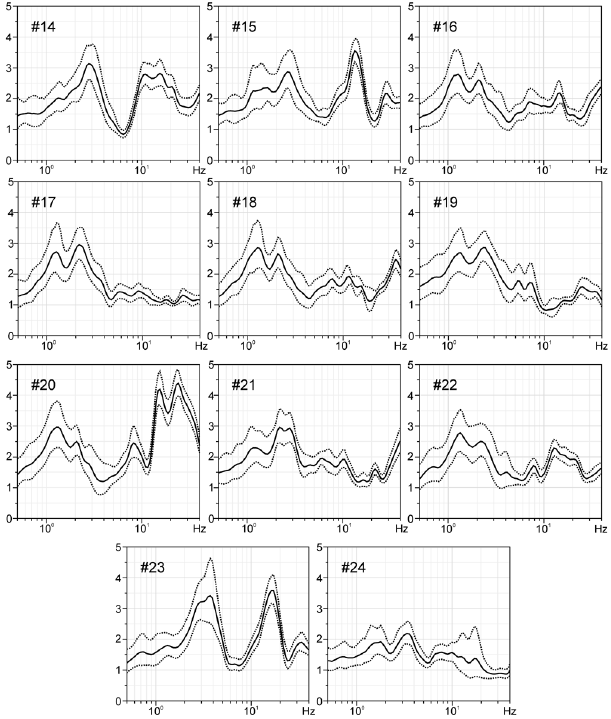
Fig. 7. HVSR results at recording sites located in the landslide